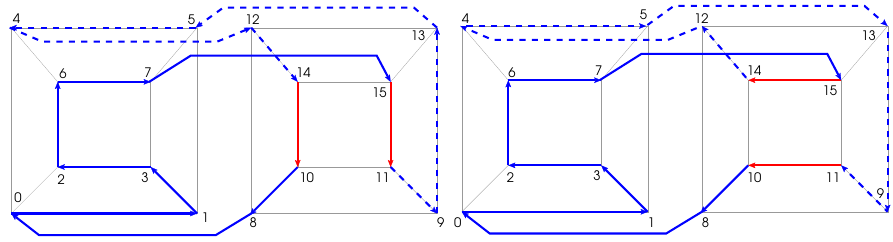
Figure 3. Inversion of sub-sequence ( 11, . . . ,14 ) (dotted line) on face (10, 11, 14, 15) in the